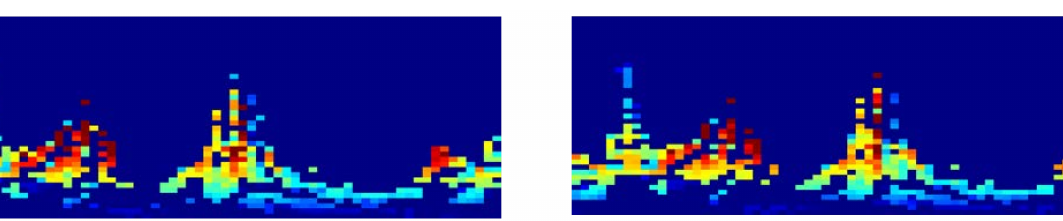
Figure 7. Illustration of place recognition for scan